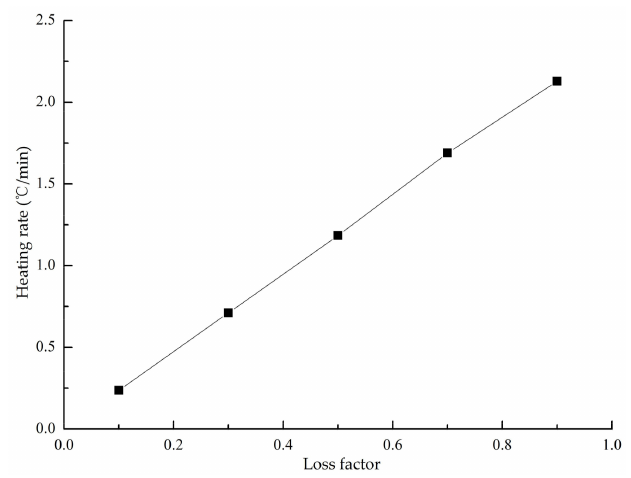
Figure 6. The graph of loss factor and heating rate.